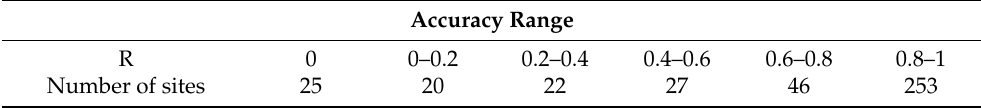
Table 6. Pearson’s coefficient R statistics for site